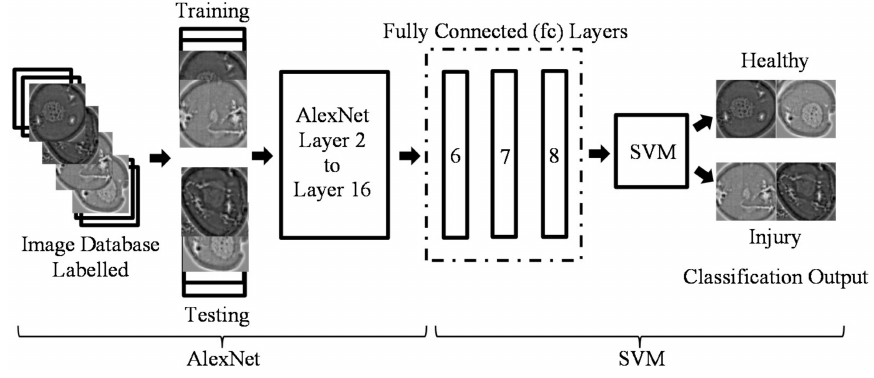
Figure 6. Feature extraction with pretrained AlexNet on cornea images classification using